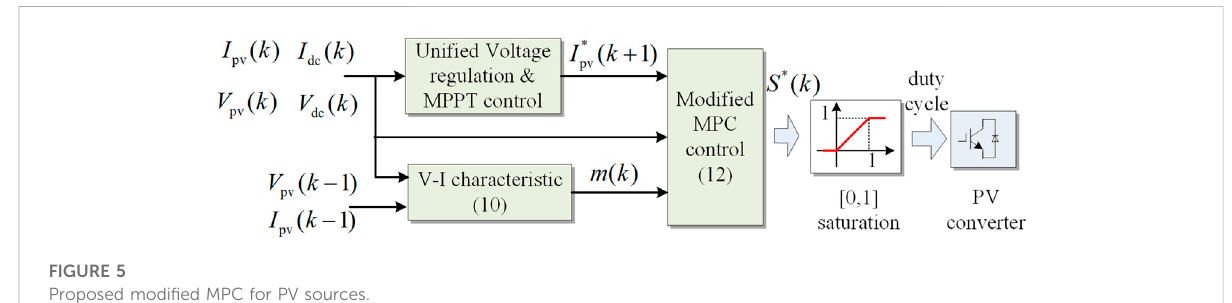
FIGURE 5 Proposed modi fi ed MPC for PV